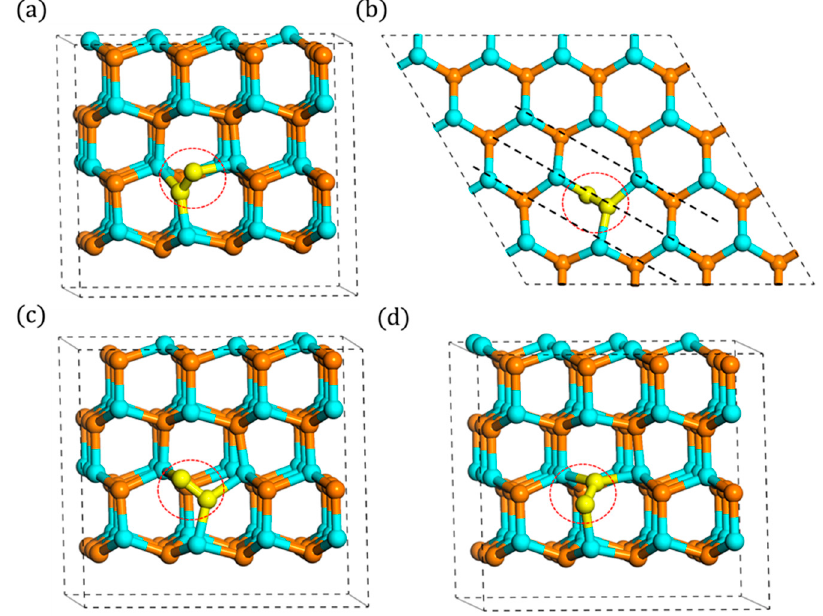
Figure 2. Configurations of split interstitial: ( a ) side view of A 1 , ( b ) top view of A 1 , ( c ) side view of A 2 , and ( d ) side view of A 3 (N i atoms are denoted by yellow spheres, the same below).